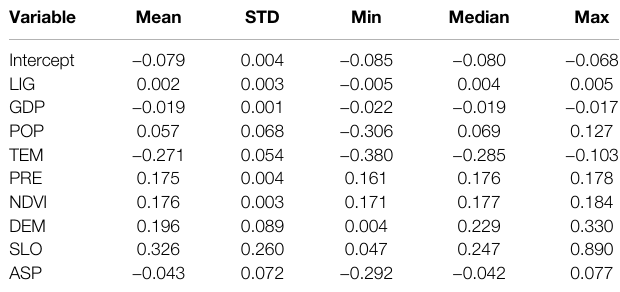
TABLE 5 | Statistical description of the MGWR coef fi cient of WY services. Variable